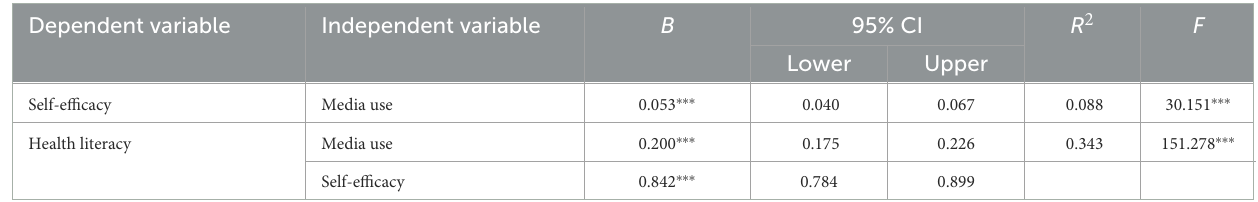
TABLE 4 Path-coefficients of the mediating model.